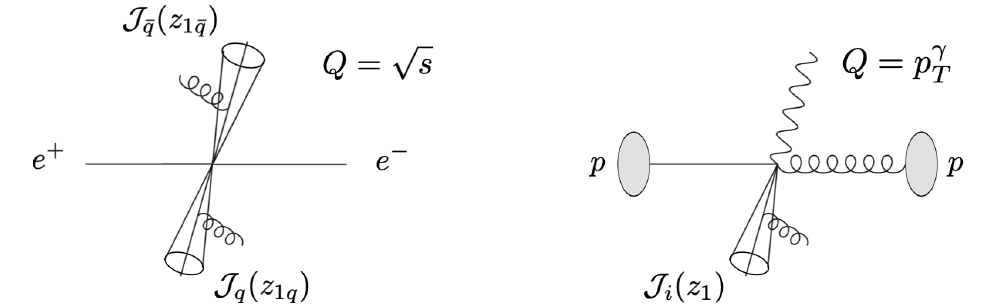
Figure 16 . Illustration of event-wide leading jets in e + e − collisions (left) and the leading jet recoiling against a direct photon in proton-proton collisions